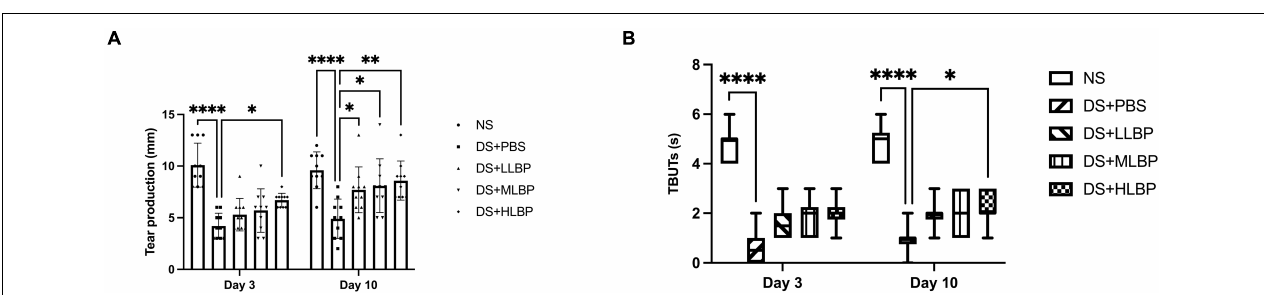
FIGURE 1 | The effects of topical application of LBP on corneal epithelial integrity and regularity in a mouse DED model. (A) Representative images of corneal fluorescein staining in different groups on days 3 and 10 after treatment. (B) The results of corneal fluorescein staining scores of different groups on days 3 and 10 after treatment. (C) Representative images of corneal irregularity in different groups on days 3 and 10 after treatment. (D) The comprehensive results of corneal irregularity scores of different groups on days 3 and 10 after treatment. Data were shown as median (IQR). ∗ P < 0.05, ∗∗∗ P < 0.001, ∗∗∗∗ P < 0.0001.